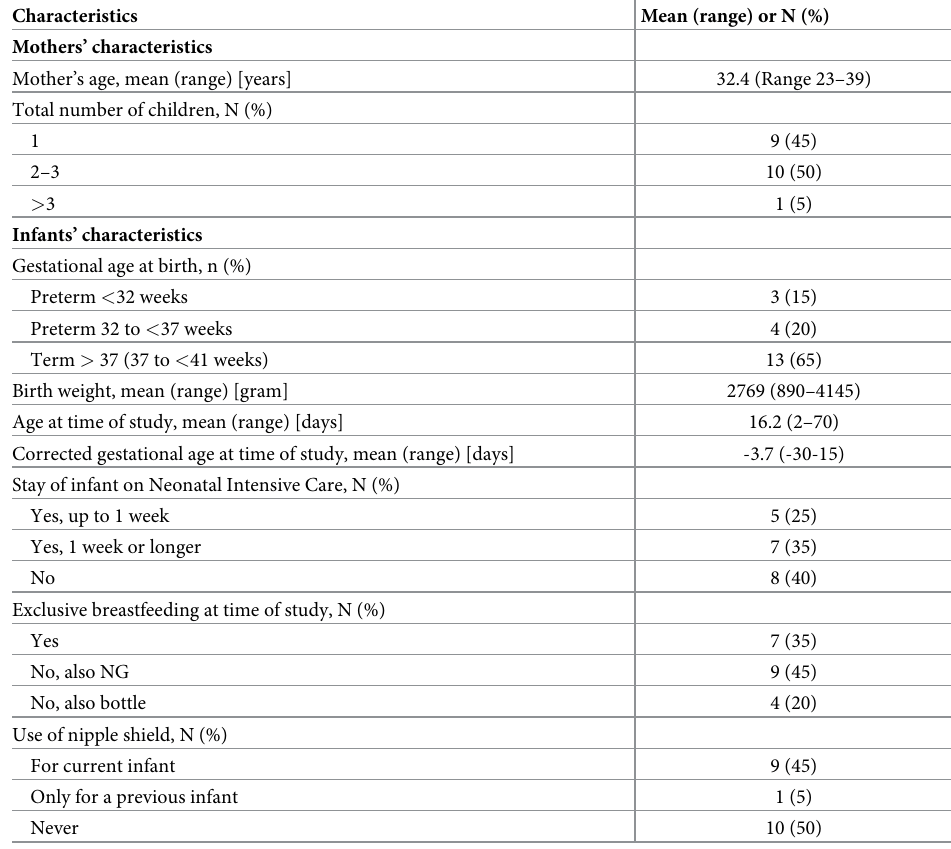
Table 1. Participant characteristics (mother-infant pairs, n = 20).